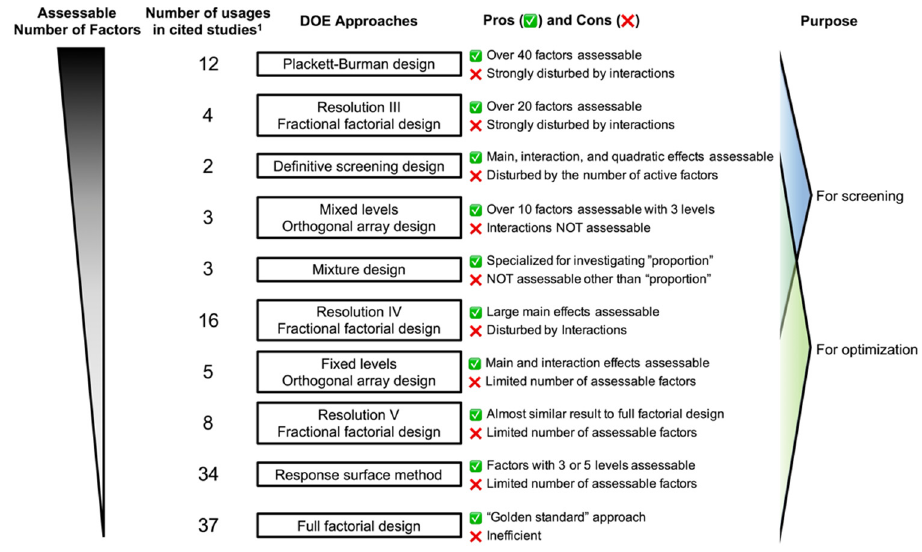
Figure 1. Pros and cons of each DOE approach. DOE, design of experiments. 1 Number of usages in cited studies were determined based on, in total, 124 DOE-based experiments.